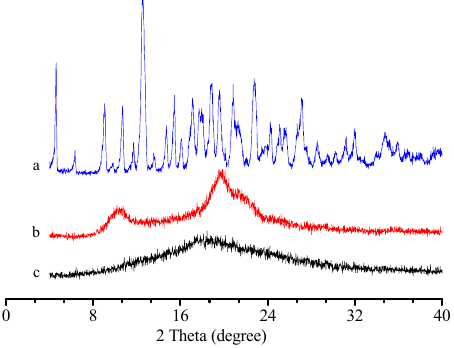
Figure 4. X-ray diffraction patterns of ( a ) β -CD; ( b ) Chitosan; and, ( c ) CGC.